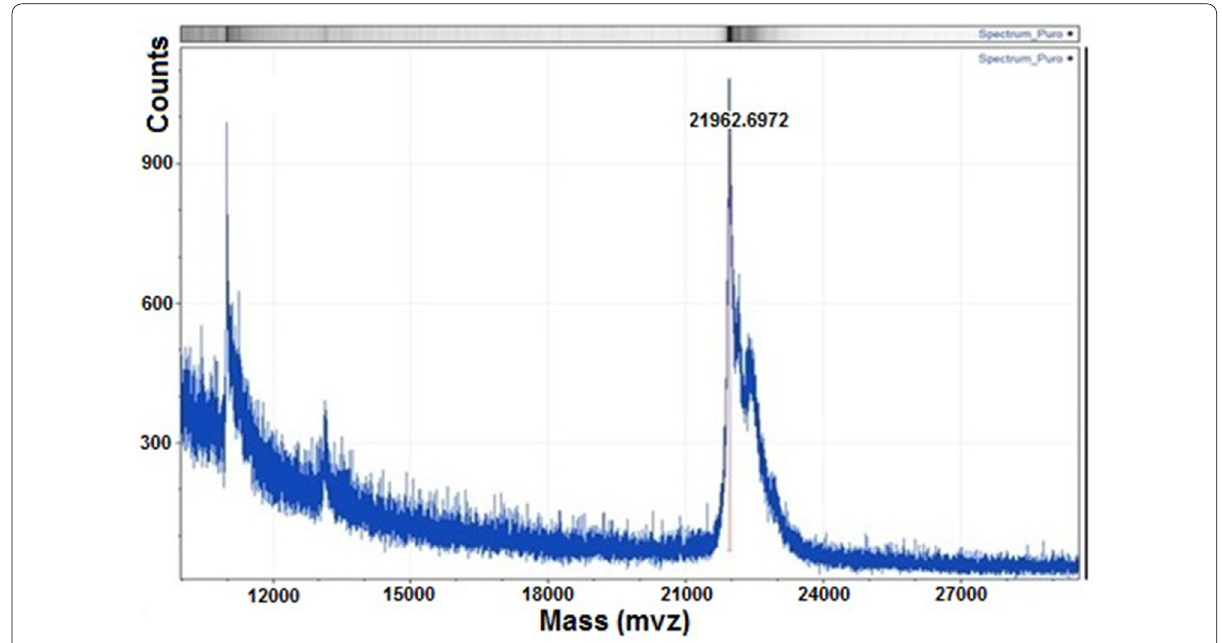
Fig.7 Example of the MALDI-TOF–MS analysis of purified Δ 1-11